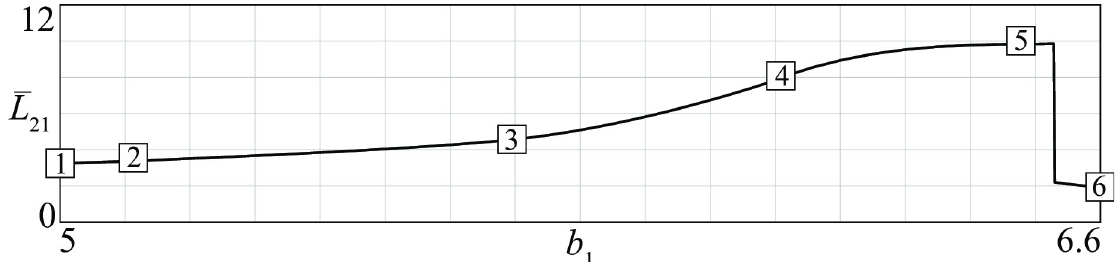
Fig 11. Mean loss � L �